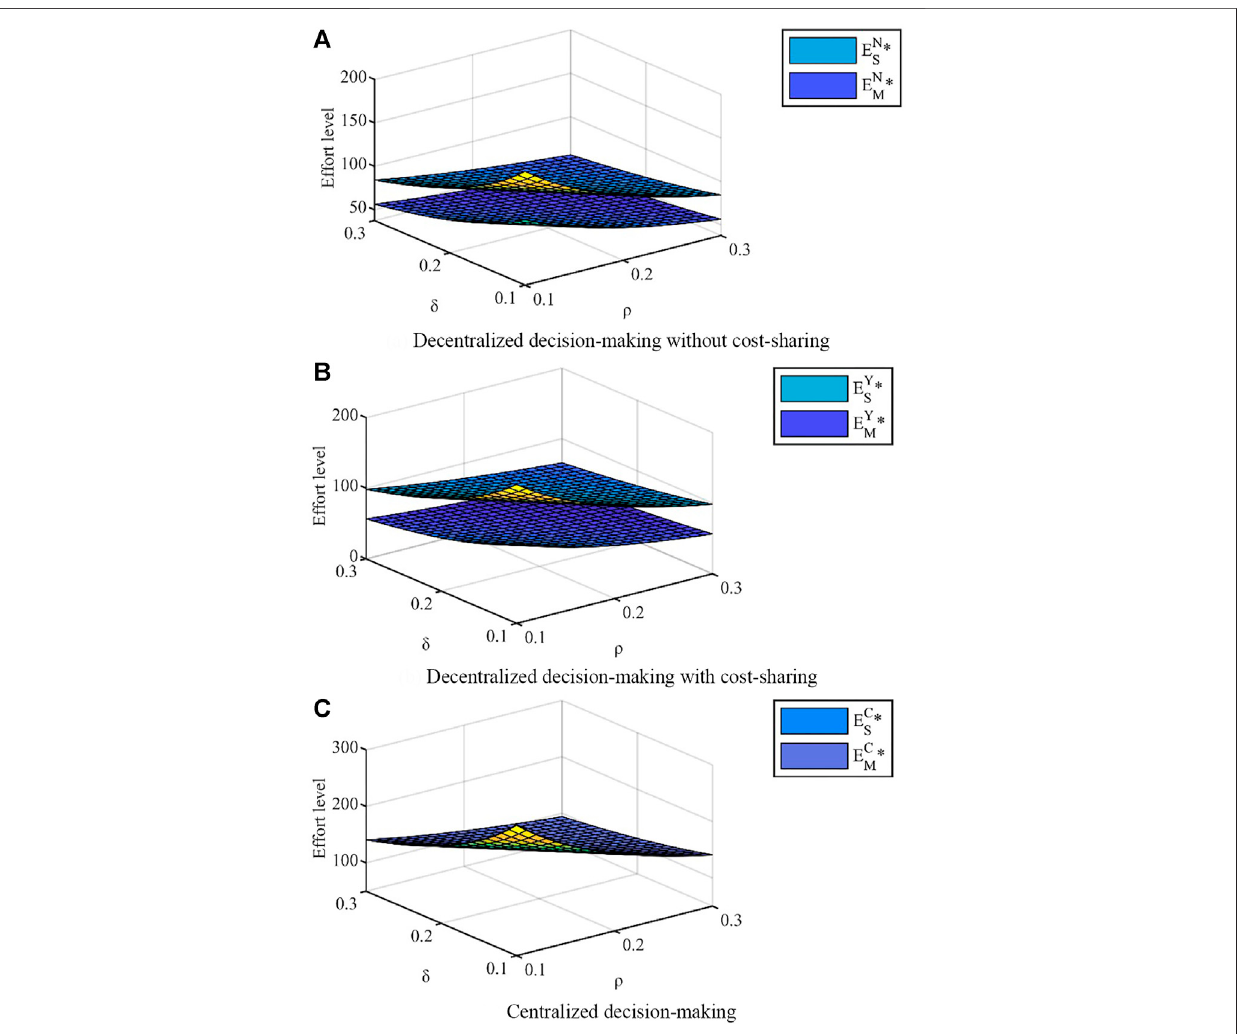
FIGURE 3 | Effort levels under different KS